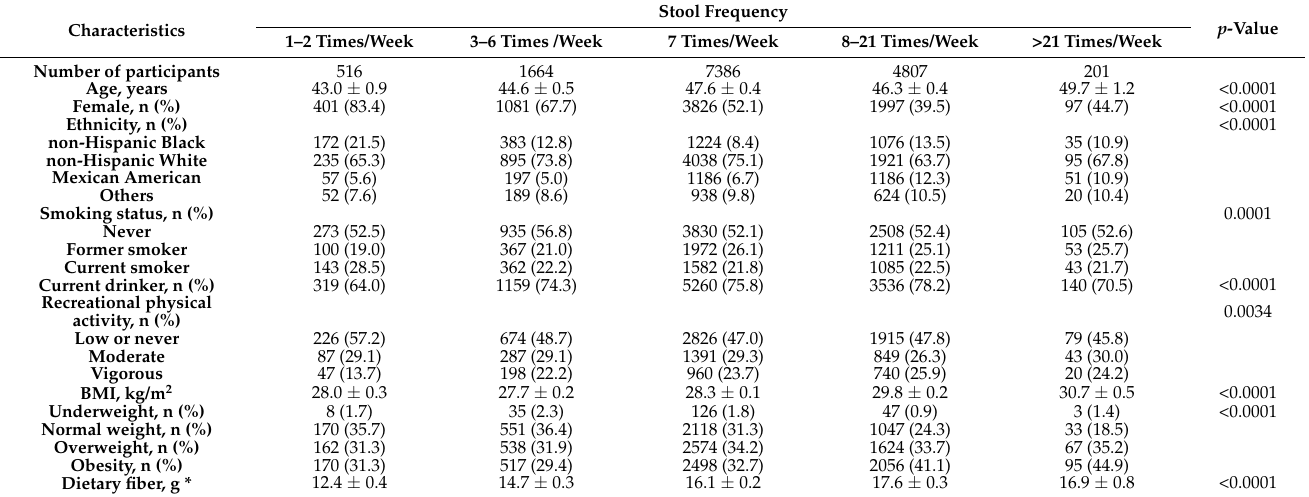
Table 2. Baseline characteristics by stool frequency among the population of NHANES